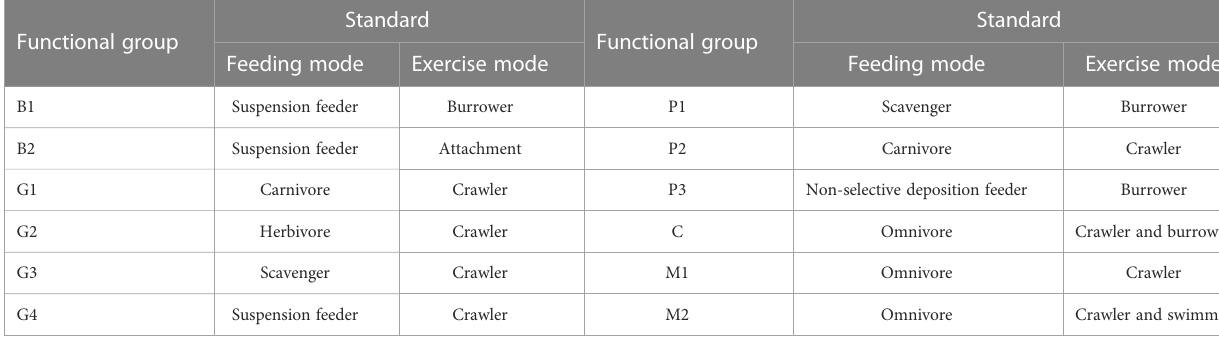
TABLE 1 Classi fi cation criteria of functional groups of